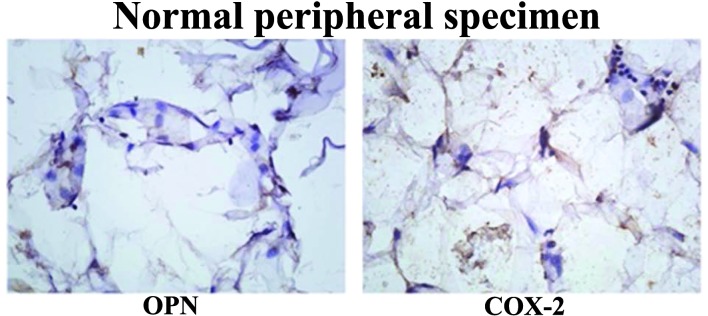
OPN and COX-2 expression in peripheral normal breast tissue. OPN, osteopontin; COX-2, cyclooxygenase-2.